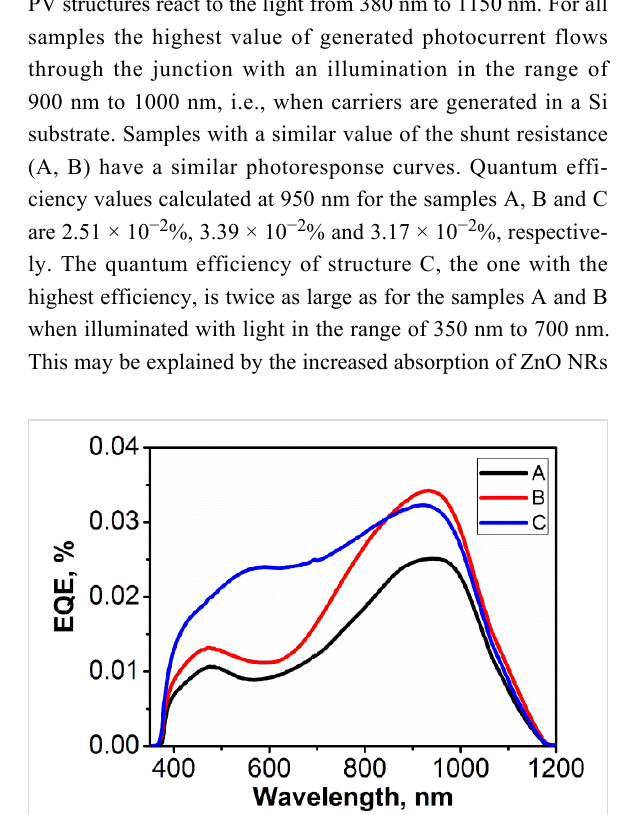
Figure 5: External quantum efficiency of the PV structures of samples A, B and C based on zinc oxide nanorods.